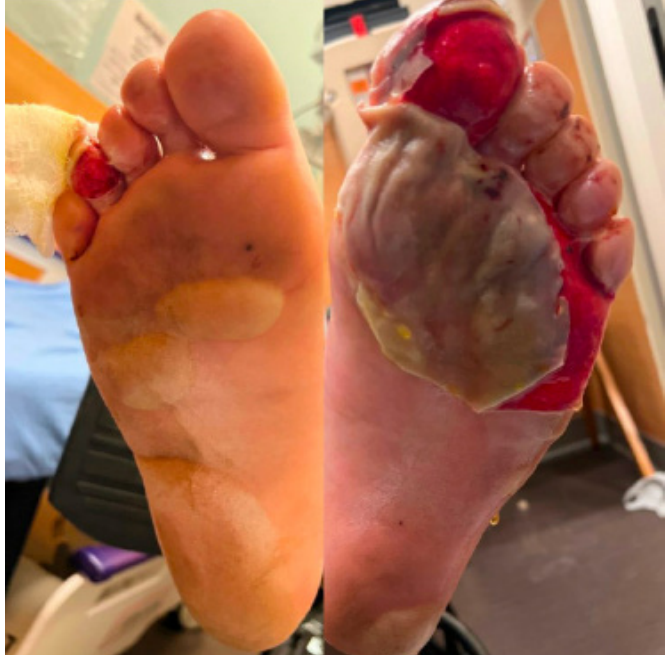
Image 2. Bilateral partial-thickness frostbite present on patient 2. Large serous blisters are